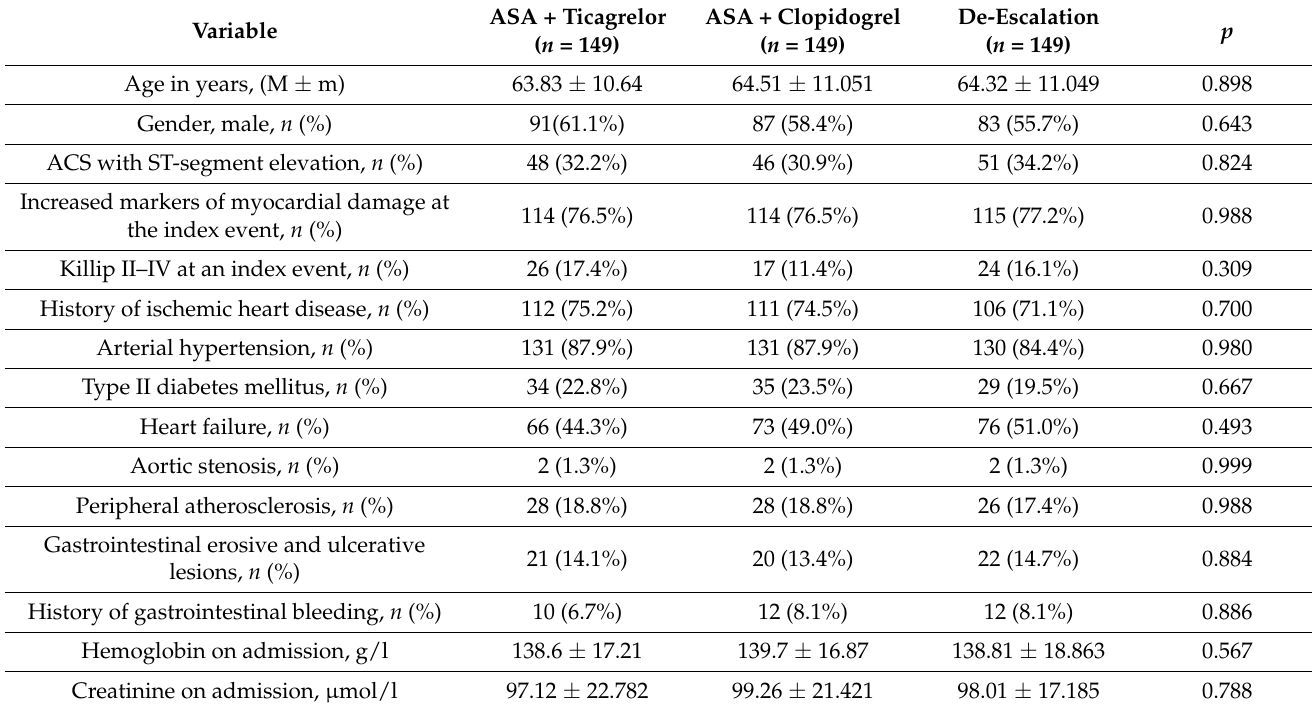
Table 5. Clinical characteristics of the groups formed as a result of